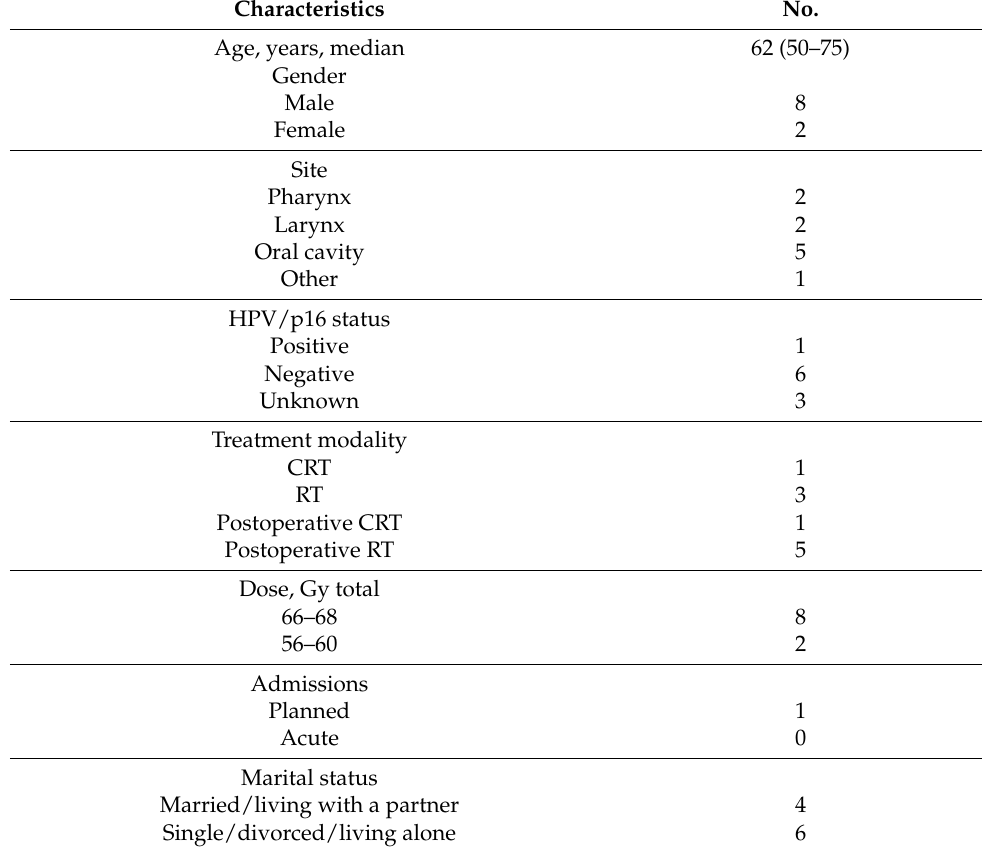
Table 1. Patient